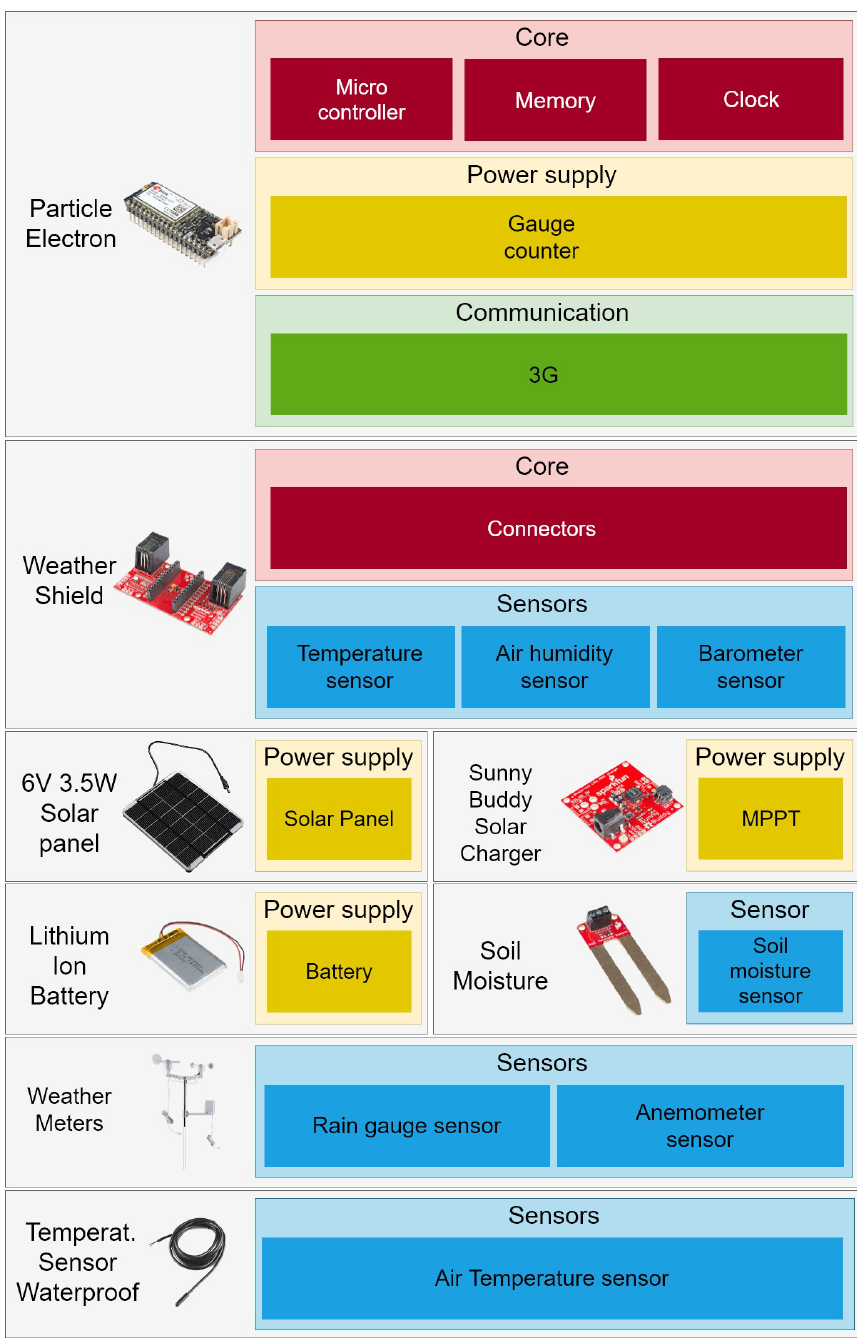
Figure 4. A list of open-hardware components to build a SEnviro